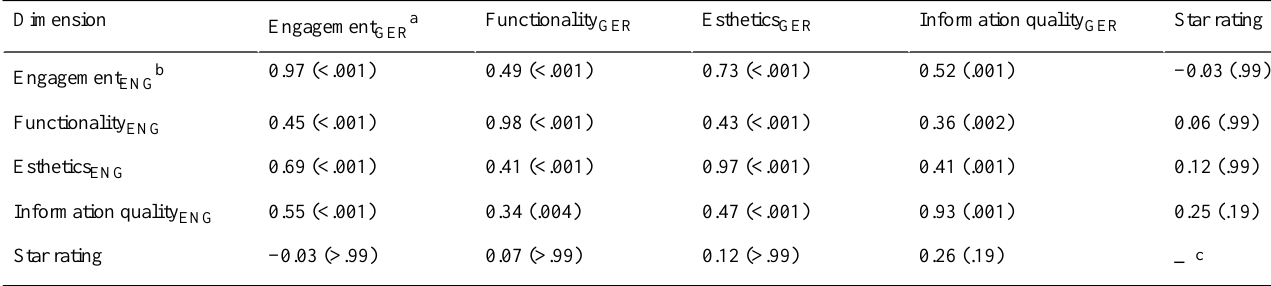
Table 2. Validity of the German version of the Mobile App Rating Scale (r and P value).